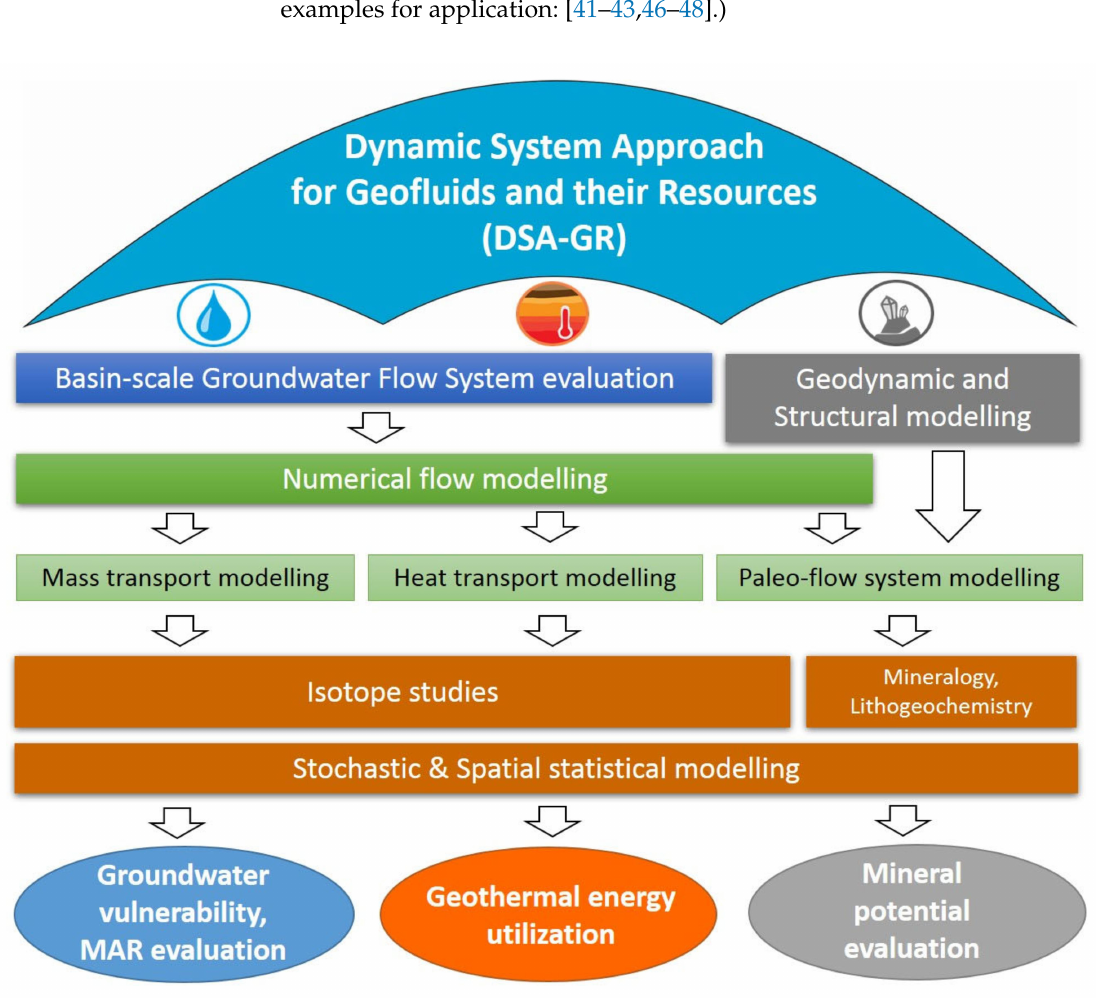
Figure 4. Workflow for geofluid